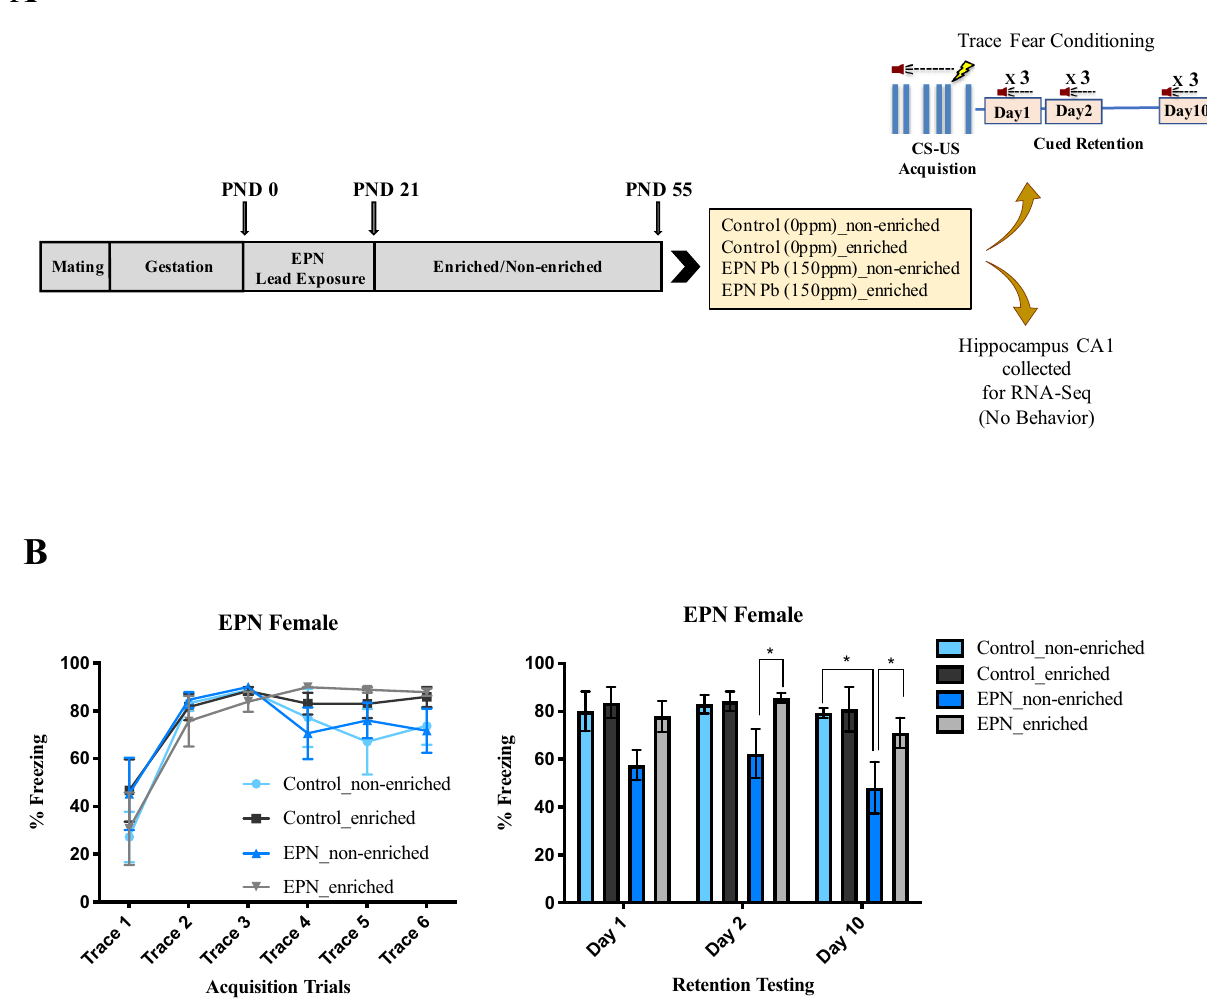
Figure 1. ( A ) Experimental study design. Long Evans rats received early postnatal (EPN) Pb exposure (150 ppm) via dams receiving Pb-containing diet beginning at postnatal day (PND) 1 through weaning (PND 21). On PND 21, female pups were randomly assigned to either the enriched or non-enriched environment. Controls (no Pb, 0 ppm) were similarly randomized to an enriched or non-enriched environment at weaning. The four experimental groups were: Control (0 ppm)_non-enriched, Control (0 ppm)_enriched, EPN Pb (150 ppm)_non-enriched, and EPN Pb (150 ppm)_enriched. At PND 55, some animals were randomly taken for trace fear conditioning while others were randomly selected for tissue collection. Behaviorally tested animals were assessed for post-conditioning memory retention at 1, 2 and 10 days after conditioning. Behaviorally naïve animals were euthanized to collect CA1 of the HIPP for RNA-sequencing. ( B ) Environmental enrichment mitigated negative effects of EPN Pb exposure on associative memory in the trace fear conditioning test.